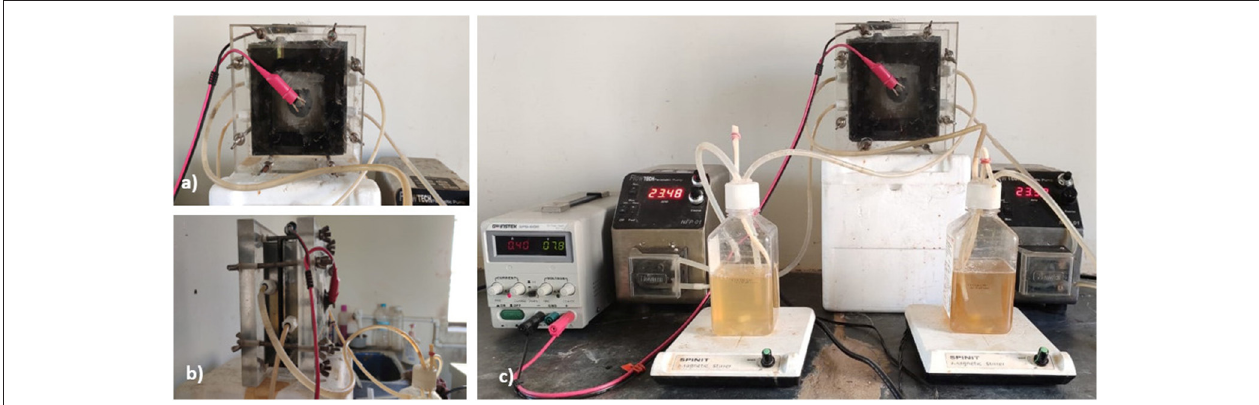
FIGURE 1 | (a) Front view of the double chamber electrochemical cell assembly. (b) Side view of the assembly showing anodic chamber with inlet at the bottom and cathodic chamber with outlet at the top. (c) Complete experimental setup for batch electrolysis experiments.